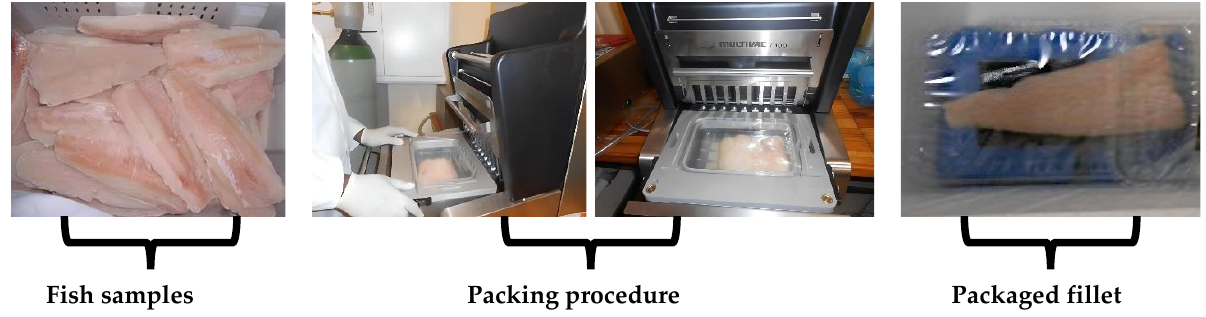
Figure 1. An illustration of the fish fillet packaging approach.